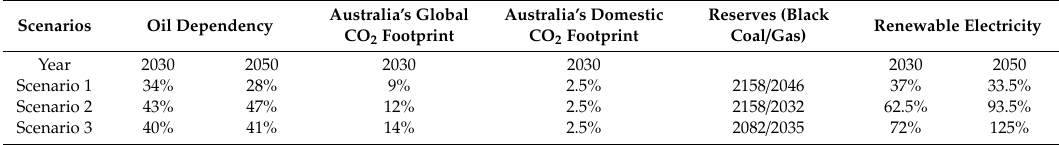
Table 2. Comparison of all energy sector development scenarios relative to the base case